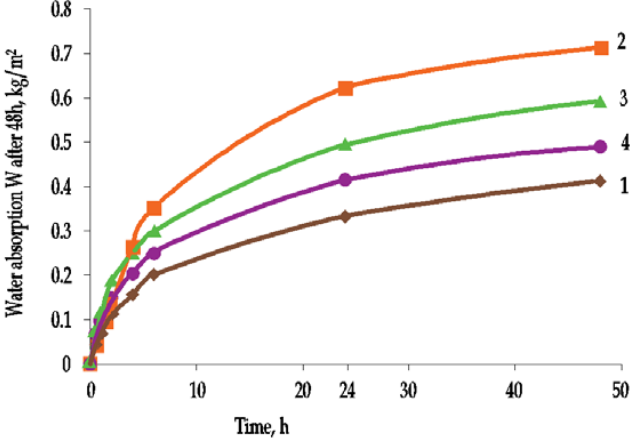
Figure 8. Surface water absorption of ETICS samples: (1) from acrylic plaster, (2) from silicate plaster, (3) from mineral plaster and (4) from silicone plaster (author’s archives based on [28]).